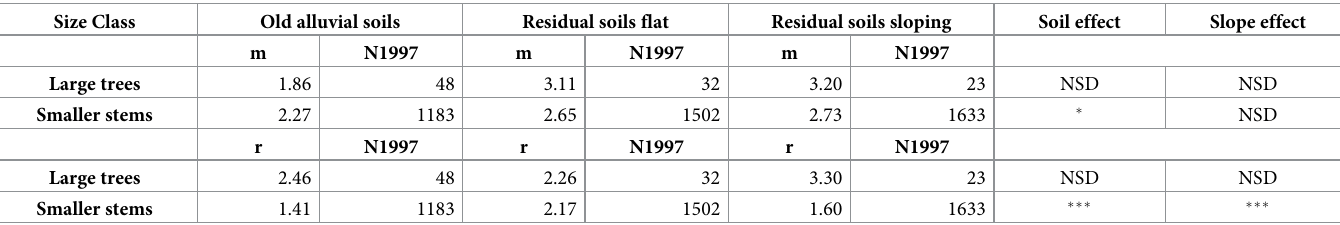
Table 8. Mortality and recruitment by edaphic